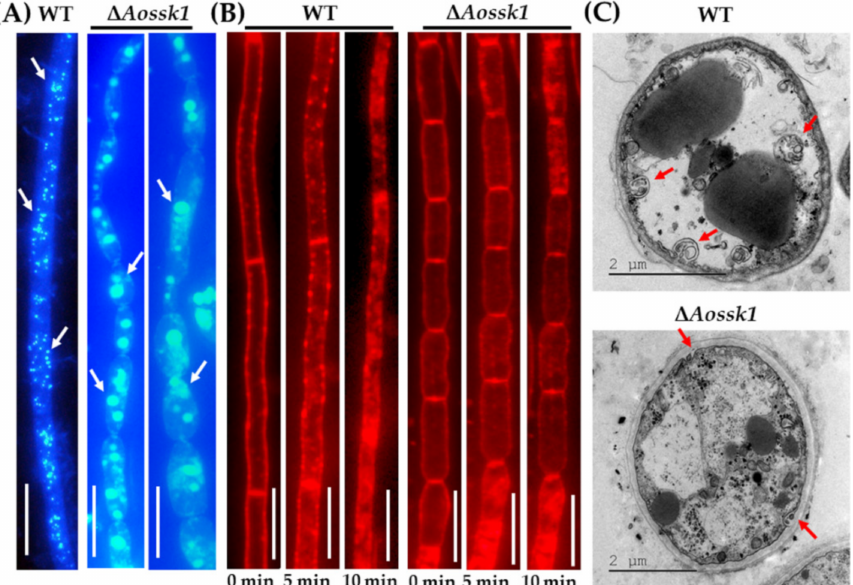
Figure 3. Comparison of autophagy and endocytosis between WT and ∆ Aossk1 mutant strains. ( A ) Comparison of autophagosomes in the hyphal cells of the WT and ∆ Aossk1 mutant strains. White arrows: autophagosomes. Bar = 10 µ m. ( B ) Endocytosis in the WT and ∆ Aossk1 mutant strains at different times; Bar = 10 µ m. ( C ) Observation of autophagic vacuole in hyphal cells using transmission electron microscopy. Red arrows: autophagic